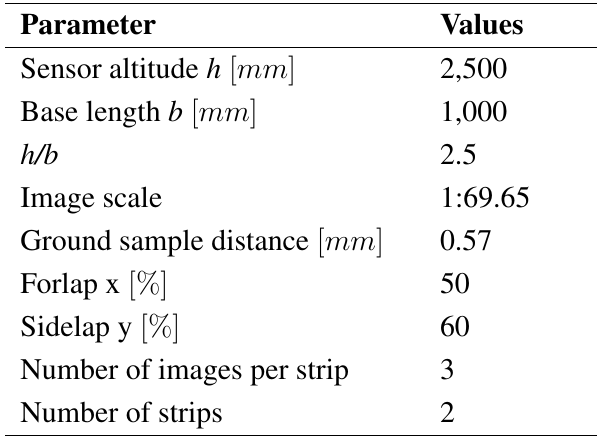
Table 3. Flight plan for the coverage of the reference frame.